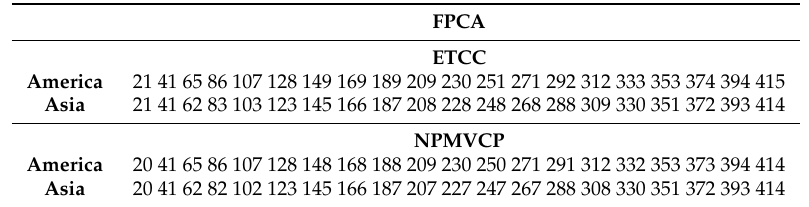
Table 21. Change point detection by ETCC and NPMVCP of FPCA with real exchange currency data of America (1/3/2013 to 10/3/2014) and Asia (1/4/2013 to 10/6/2014).